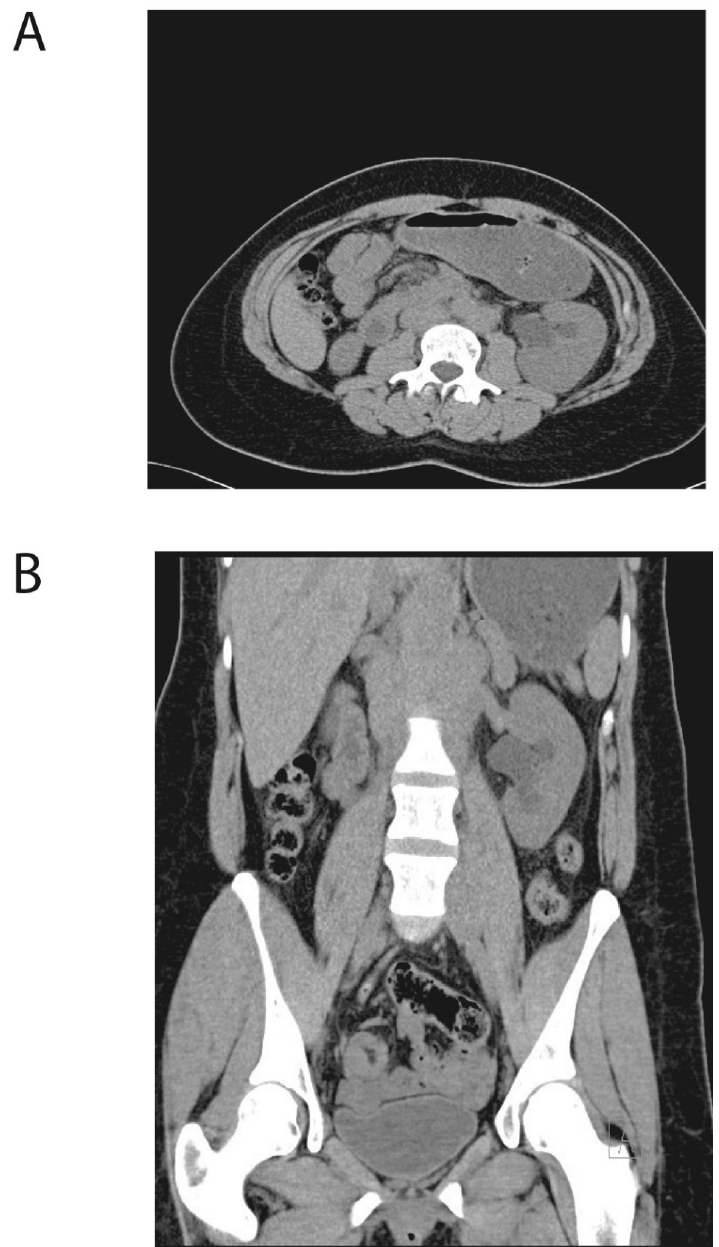
Figure 1. Initial computed tomography (CT) scan of the urinary tract. ( A ) Transversal plan and ( B ) frontal plan. The initial CT of the patient’s abdomen, revealing normal kidney parenchyma. The renal pelvis of the left kidney shows dilation compared to right side. The left ureter is dilated and S-shaped near the renal pelvis.